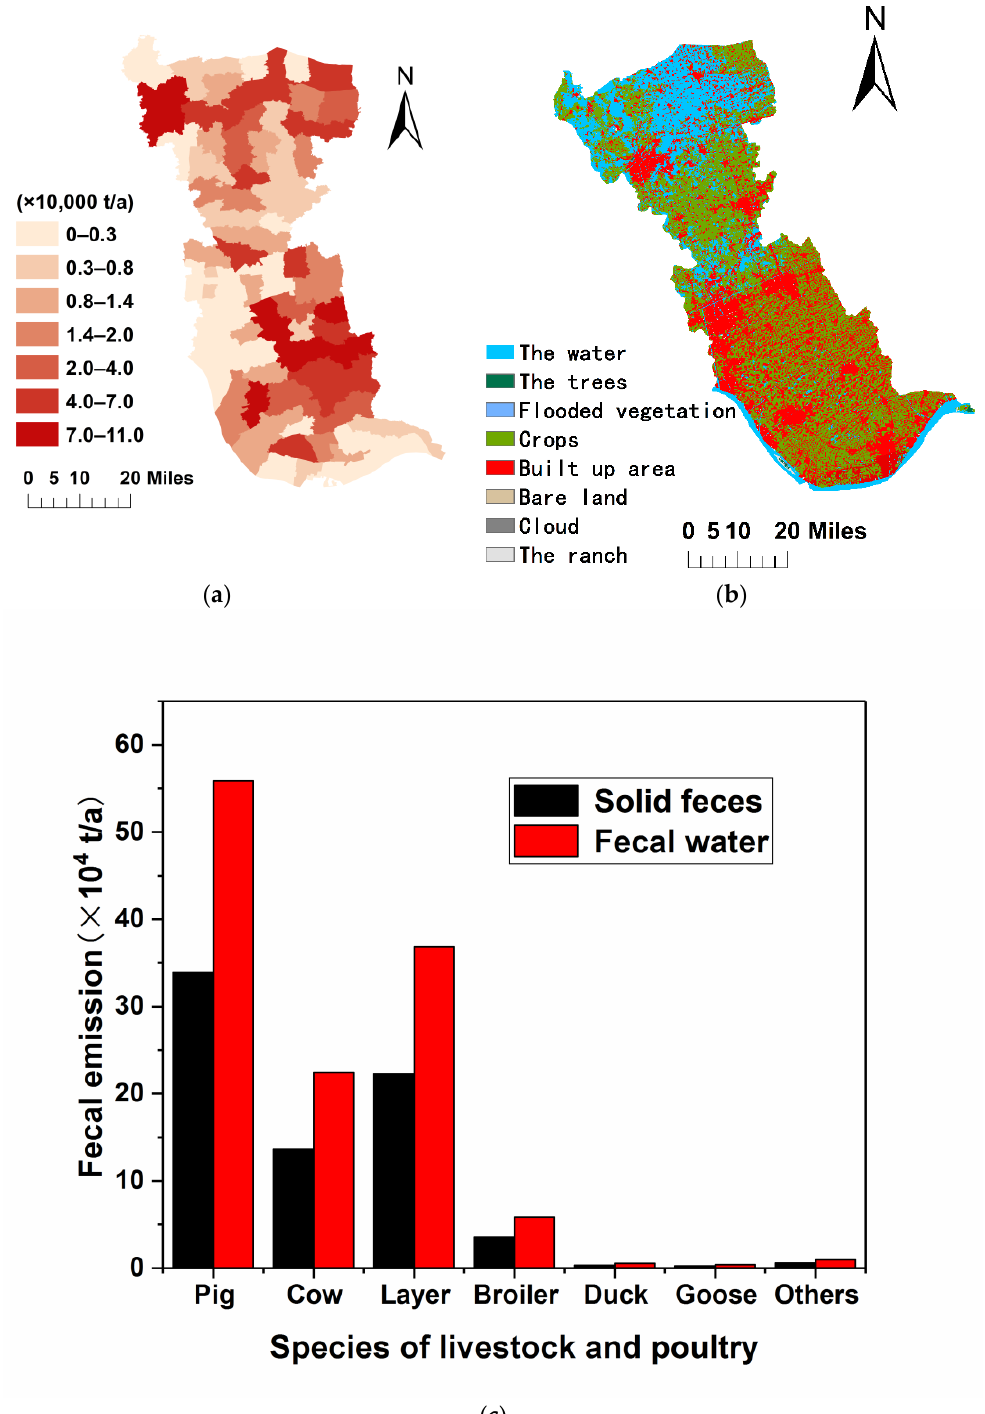
Figure 2. ( a ) Livestock and poultry manure emissions in township scale (in terms of pig equivalents); ( b ) land use in the study area; ( c ) manure emissions of different types of livestock and poultry.